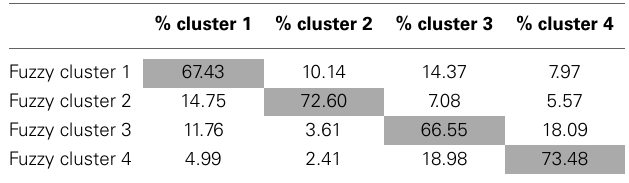
Table 4 | Summary of clustering membership in percentage for fuzzy